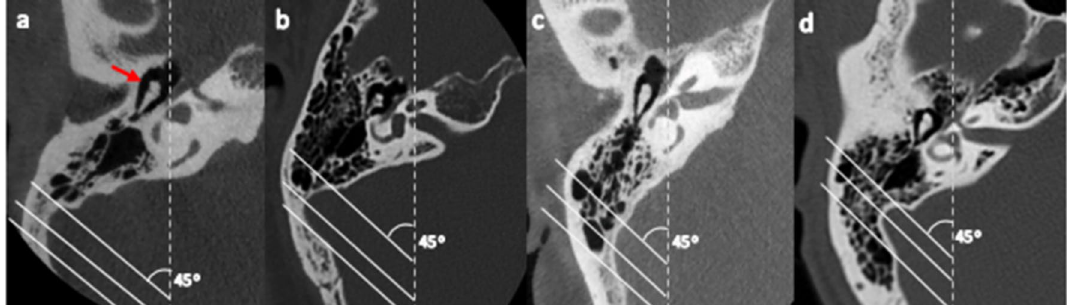
Figure 4. Degrees of pneumatization by evaluating air cells around the sigmoid sinus. Axial section where the malleoincudal complex (red arrow) appeared as an ice-cream-cone shape. Three parallel lines were drawn angled at 45˚ to the anteroposterior axis (dotted line). ( a ) Hypo-pneumatization: pneumatization remains anteromedial to the anterior line (passing the most anterior point). ( b ) Moderate pneumatization: pneumatization between the anterior and middle lines (passing the most lateral point). ( c ) Good- pneumatization: pneumatization between the middle and posterior lines (passing the most posterior point). ( d ) Hyper-pneumatization: pneumatization extends posterolaterally beyond the posterior line.